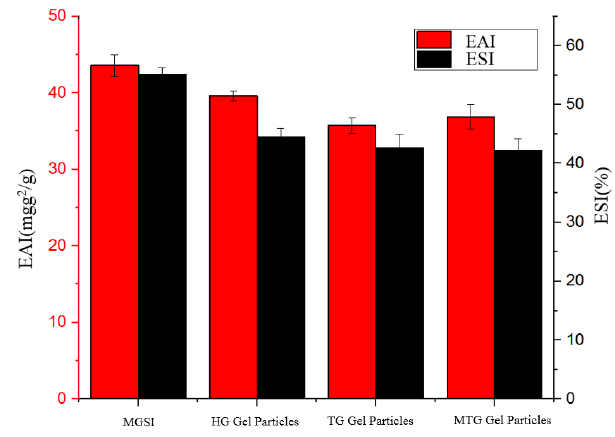
Figure 5. Emulsification analysis of different gels.